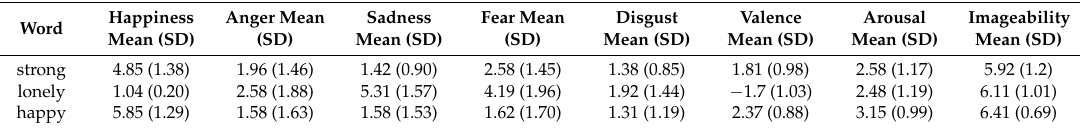
Table 4. Sample annotations of words from the NAWL (Nencki Affective Word List)